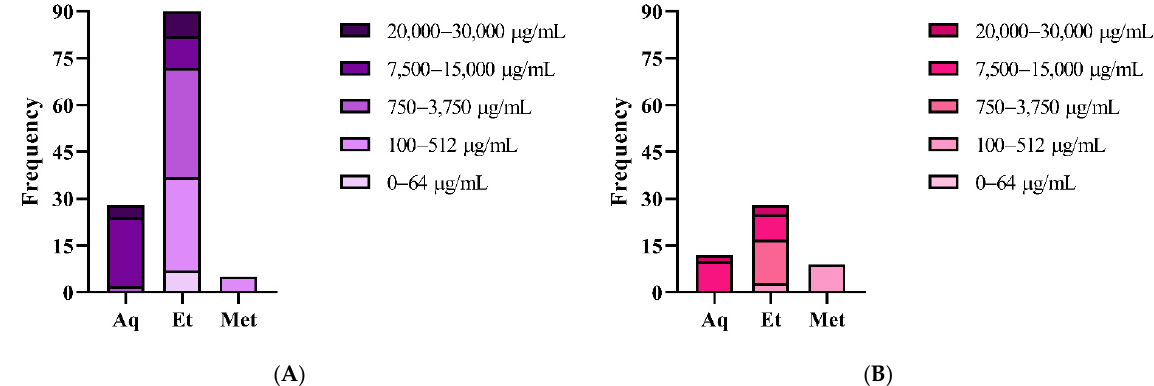
Figure 4. Antibacterial activity of Brazilian propolis against Gram-positive and negative bacteria. Distribution of the MICs found in the 13 studies utilized. ( A ) Gram-positive bacterial species ( B ) Gram-negative bacterial species. Frequency: number of times a MICs was found in that interval. EtGP, ScGP, EtRP, ScRP, EtBP, and ScBP. Gram-positive microorganism: Staphylococcus (spp. aureus ATCC 25923, 25913, 3359, epidermidis 25/4, 194/2), Enterococcus spp, Enterococcus faecalis , Corynebacterium pseudotuberculosis , Eubacterium lentum , Peptostreptococcus anaerobius , Streptococcus ( mutans , sobrinus , pyogenes 93007, 75194, sanguinis , salivarius ), Actinomyces naeslundii , Lactobacillus casei , Paenibacillus larvae . Gram-negative microorganism: Escherichia coli , Klebsiella spp., Aggregatibacter actinomycetemcomitans , Fusobacterium ( nucleatum , necrophorum ), Porphyromonas gingivalis , Prevotella ( intermedia , nigrescens ), Pseudomonas aeruginosa [26,34,35,37,59,60,75–80].